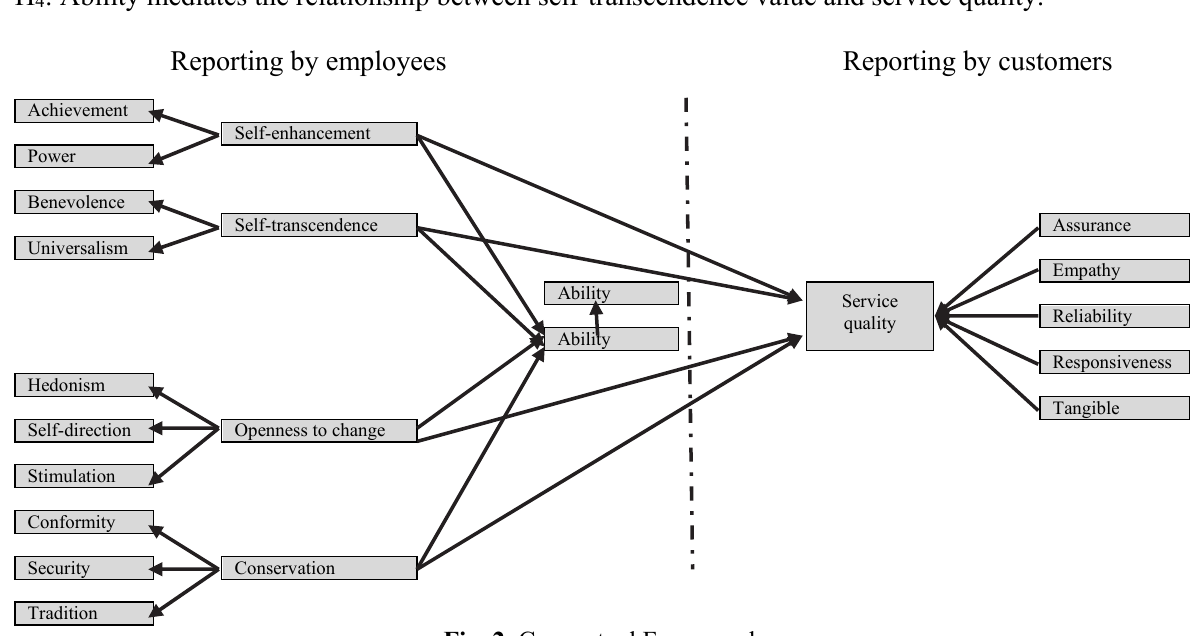
Fig. 2 . Conceptual